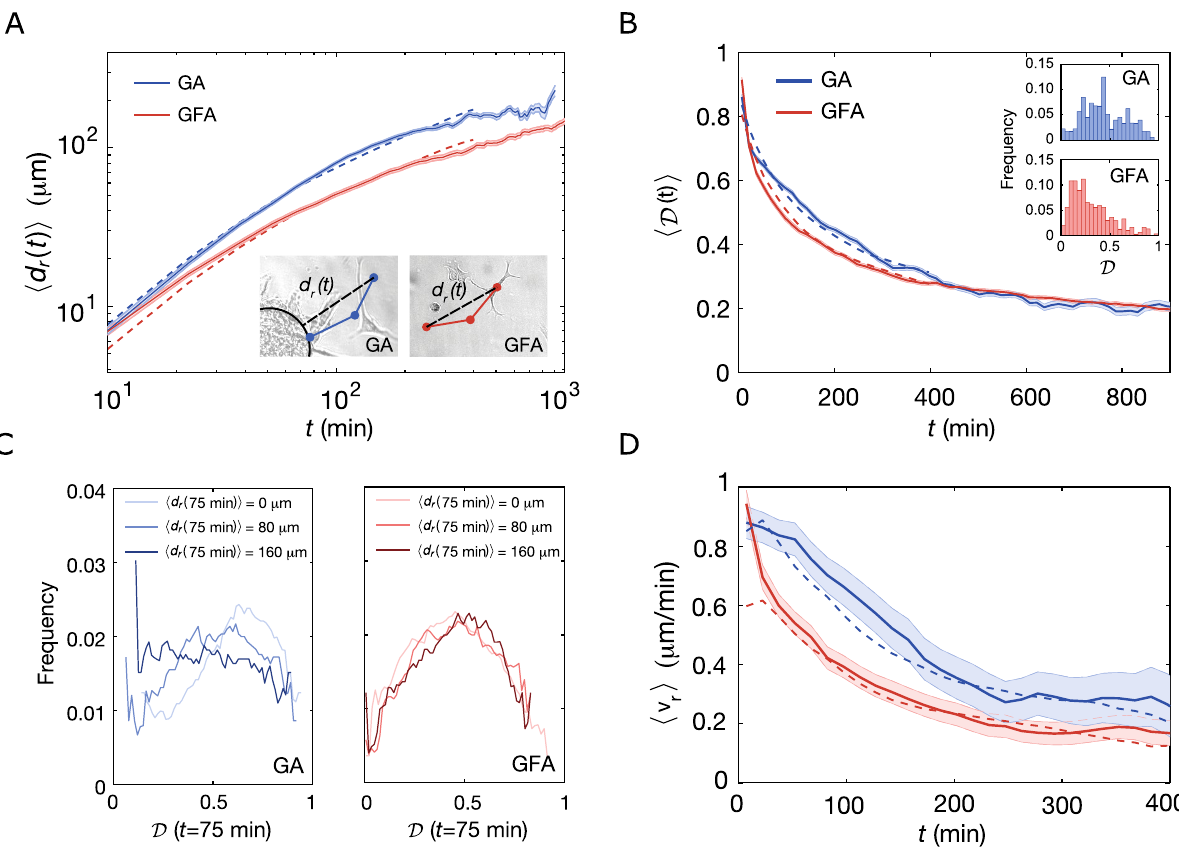
Figure 4. Time evolution of migration patterns. ( A ) Time-dependent ensemble-averaged radial displacement, (cid:31) d r ( t i ) (cid:30) , versus time, t , (mean ± SEM) for GA (N=177) and GFA (N = 305) on a double-logarithmic scale. Dashed lines correspond to results obtained from BPRW (blue) and PRW (red) simulations. Insets: Sketches defining the radial displacement, d r ( t i ) , for GA and GFA, respectively. ( B ) Time evolution of the ensemble- averaged directionality, (cid:31) D ( t i ) (cid:30) (mean ± SEM) for GA (N = 177) and GFA (N = 305). The dashed lines are averages over simulated tracks for BPRW (blue) and PRW (red). Insets: Distribution of the directionality of the entire trajectories, D . ( C ) Distribution of directionalities of the trajectories after t = 75 min, D ( 75 min ) , at different distances from initial position, (cid:31) d r ( 75 min ) (cid:30) , for GA (blue) and GFA (red). ( D ) Time-evolution of the ensemble-averaged radial velocity, (cid:31) v r ( t i ) (cid:30) , (mean ± SEM) for GA and GFA and simulated trajectories (dashed lines) from BPRW (blue) and PRW (red). In all four cases, (cid:31) v r ( t i ) (cid:30) was binned over 15 min with a moving average of 10 data points.